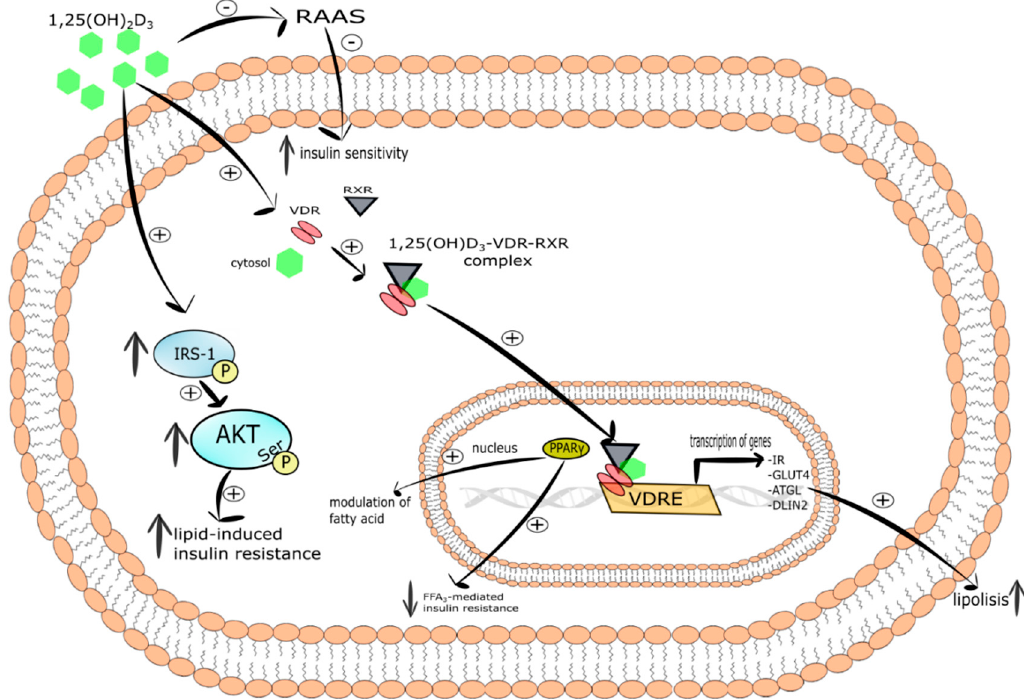
Figure 6. The mechanism of vitamin D action in myocyte. Stimulatory interactions are indicated by + and inhibition by -; ↓ denotes decrease ↑ denotes increase.